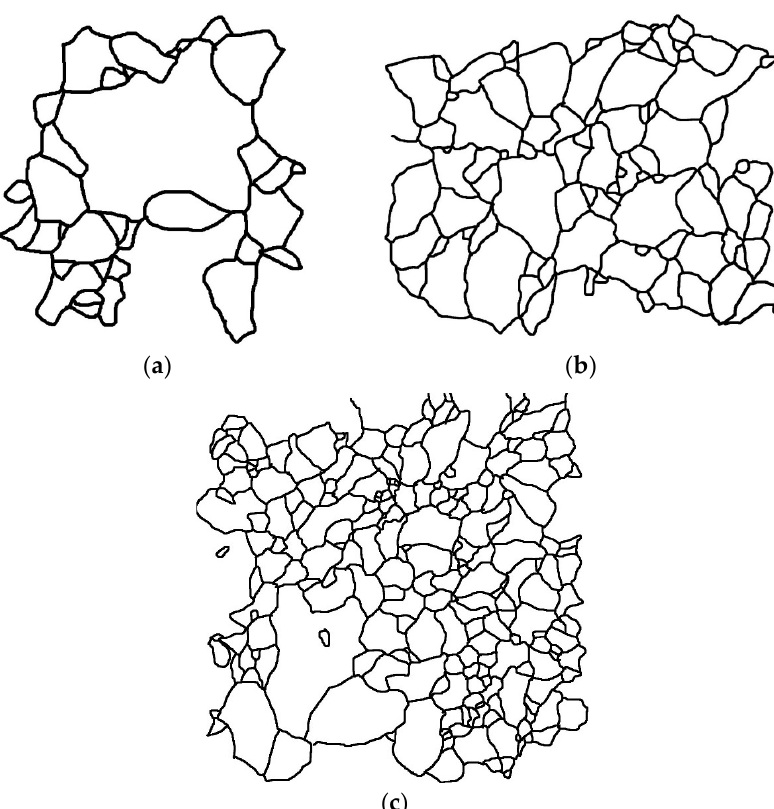
Figure 3 . Optical micrographs of the martensitic sample quenched from recrystallized austenite revealed by Bechet-Beaujard etching [6] in the areas corresponding to the EBSD scans of Figure 2. ( a ) 350 × 350 μm 2 ; ( b ) 800 × 700 μm 2 ; and ( c ) 900 × 900 μm 2 . In ( a , b ), the arrows represent boundaries which show weaker contrast and/or which do not close to define grains.